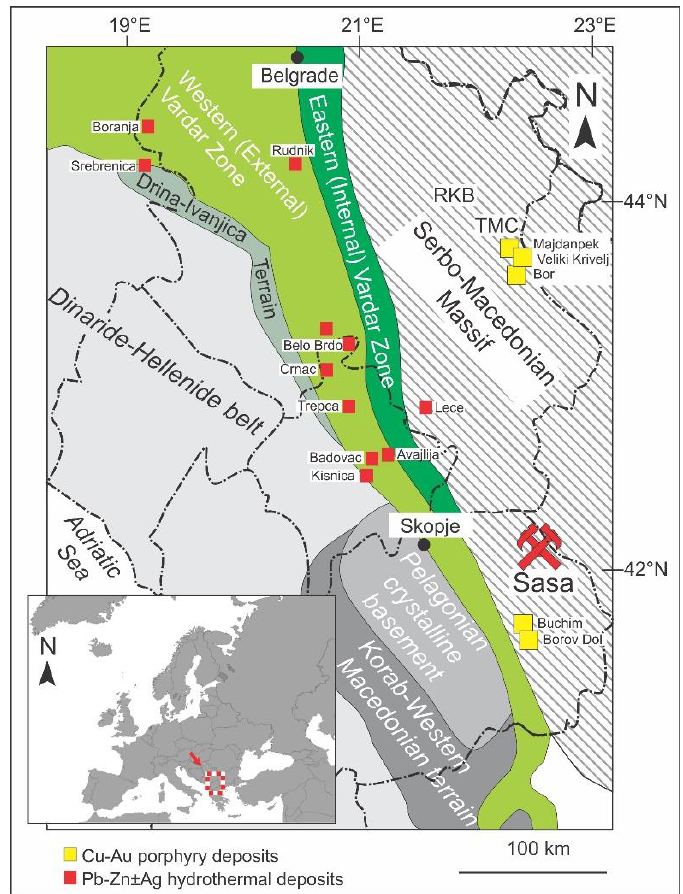
Figure 1. Regional geologic setting of the Sasa Pb-Zn-Ag skarn deposit, Republic of Macedonia, within the Balkan Peninsula (according to [13,14]). The locations of the most prominent Pb-Zn ± Ag hydrothermal and Cu-Au porphyry deposits are also marked. Abbreviations: RKB = Ridanj–Krepoljin belt, TMC = Timok magmatic complex.